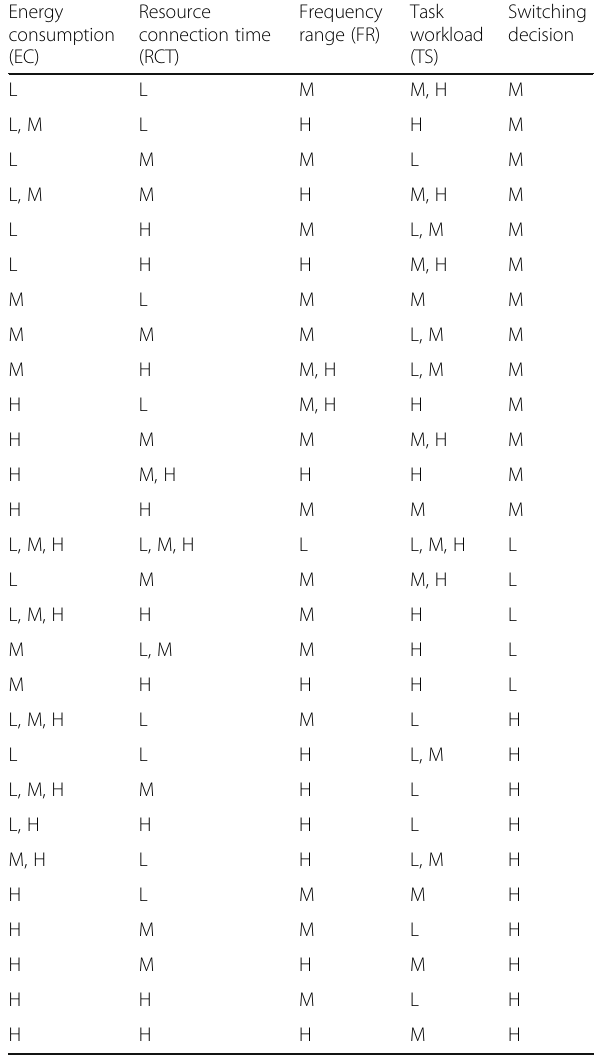
Table 5 Resource switching criteria Energy